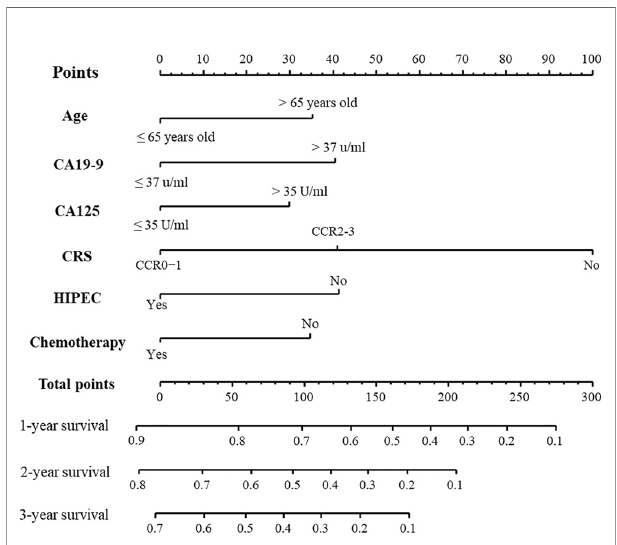
FIGURE 2 | Nomogram for predicting the OS of CRC patients with S-PM. The C-index of this nomogram is 0.701 (95% Cl, 0.666 –